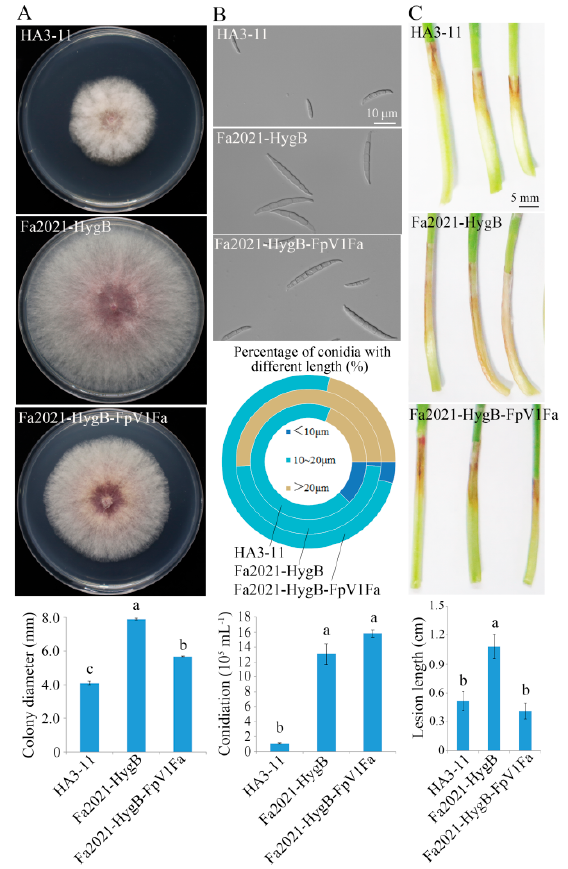
Figure 3. Impact of FpV1 ‐ Fa on F. asiaticum biological properties. ( A ) Colony morphology and growth rate of virus ‐ free and ‐ infected F. asiaticum strains 3 days after inoculation. Mycelial plugs are inoculated and cultured on PDA for 3 days at 25 °C in the darkness. The experiment is repeated three times. Values are means ± SD of three independent biological duplicates. ( B ) Macroconidia morphology and conidiation of virus ‐ free and ‐ infected F. asiaticum strains 5 days after inoculation. Lengths of conidia produced in CMC medium after 5 d. A total of 100 conidia is examined to detect the length and septa number for each strain. Experiments are performed in triplicate. ( C ) The vir ‐ ulence of virus − free and − infected F. asiaticum strains on wheat seedlings, as indicated by lesion length. Lesions are measured at 7 dpi and values are means ± SD of 30 replicate seedlings. Means with different letters are significantly different at p < 0.05.